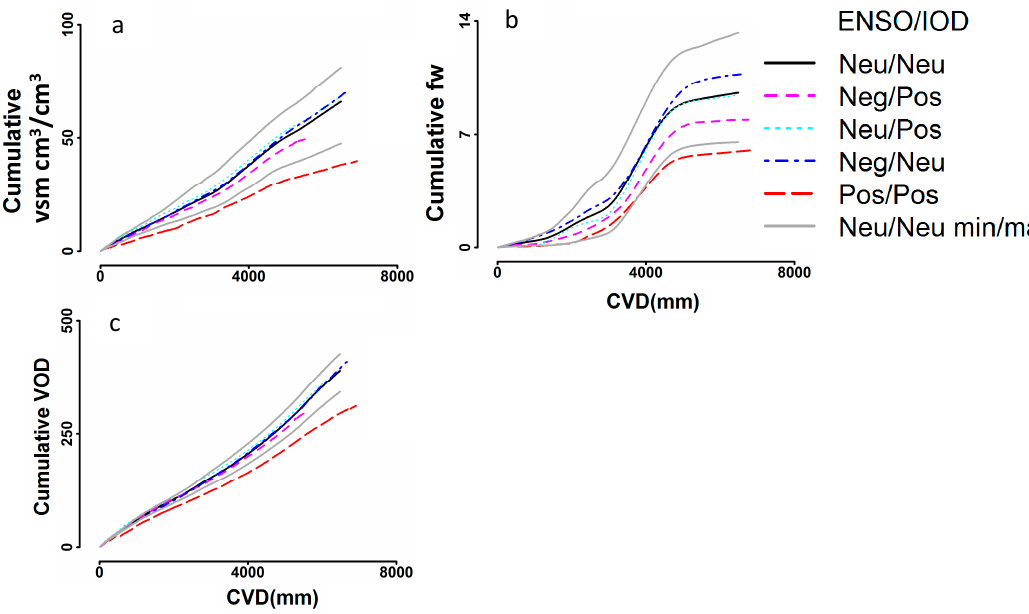
Figure 16. Time series of ( a ) cumulative volumetric soil moisture (vsm), ( b ) cumulative fractional water (fw), and ( c ) cumulative vegetation optical depth (VOD) in Central Ethiopia. The neutral ENSO/IOD years are represented by the black line, while the maxima and minima of this combination are represented by gray. The rest shows other possible combinations of ENSO/IOD.